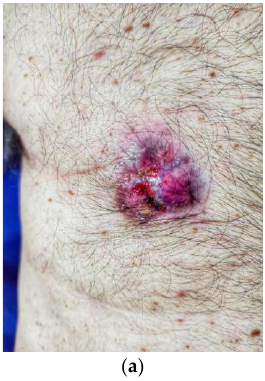
Figure 11. Local cancer recurrence in a patient with a history of subcutaneous mastectomy and sub- sequent breast implantation reconstruction. The tiny tumor foci are better depicted at 22 MHz ( a ) than at 15 MHz ( b , arrows).